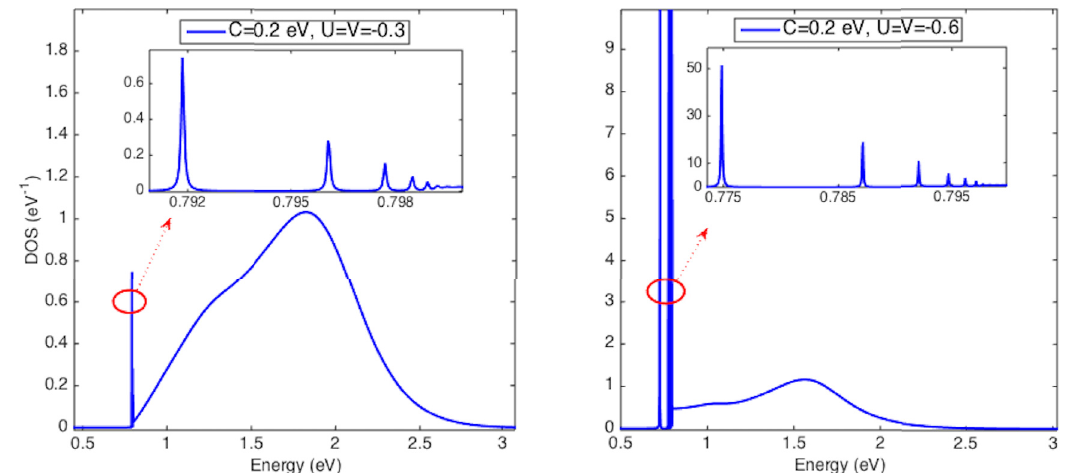
Fig. 7. LDOS as a function of the energy of the absorbed photon under the influence of long-range electron-hole